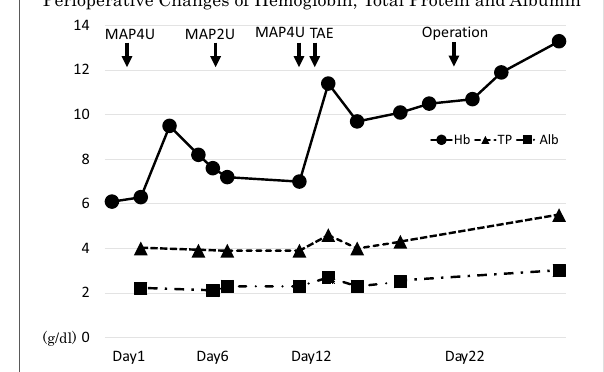
Fig. 3 A chart of the perioperative course of hemoglobin, total protein and serum albumin levels showed that remission of anemia has been obtained after TAE. And elective surgery could be carried